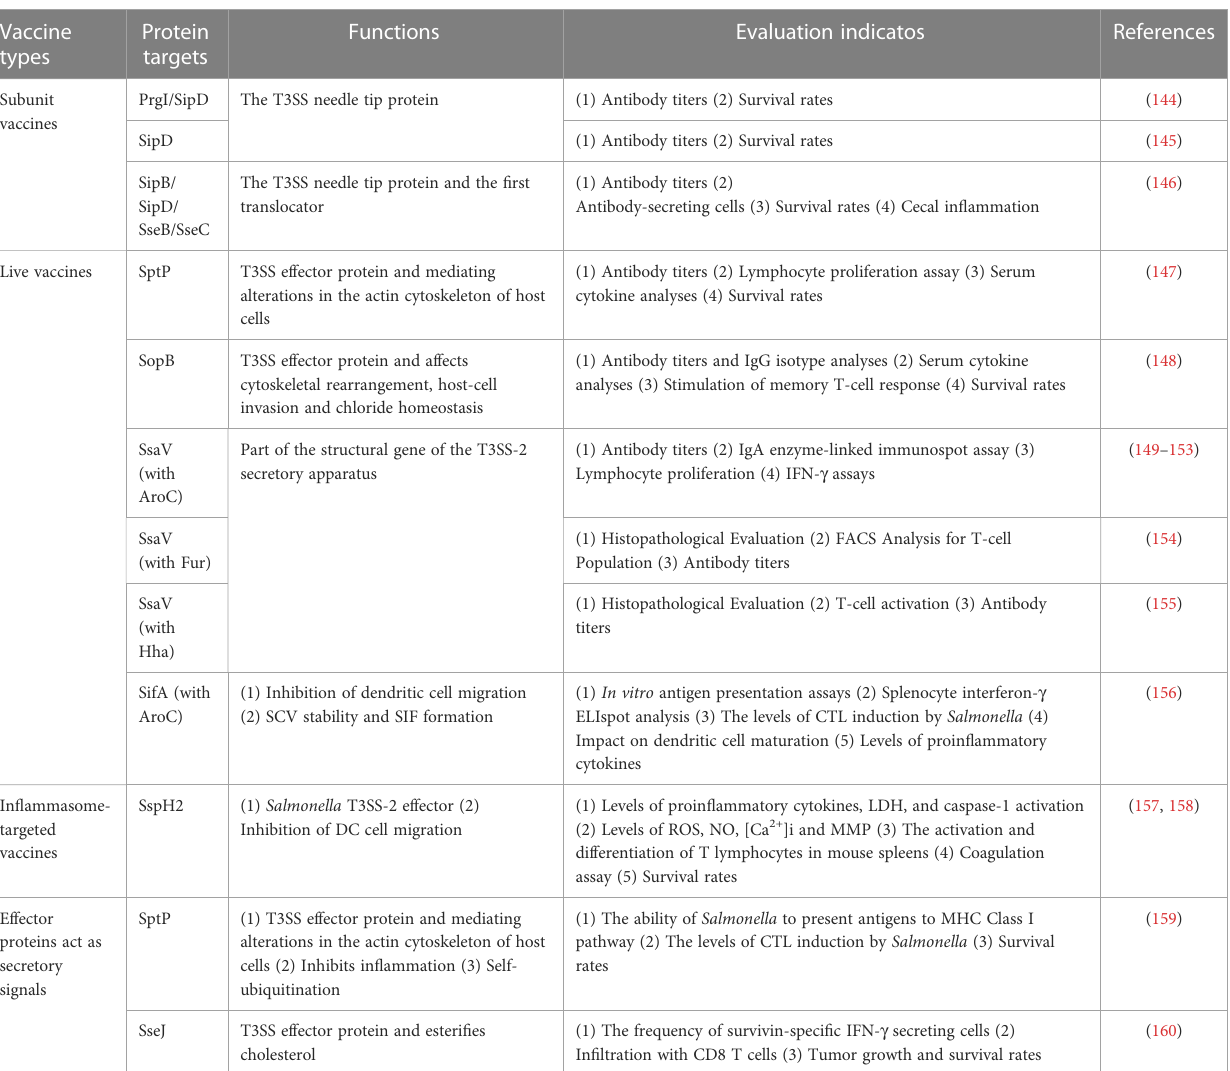
TABLE 2 Application of effector proteins in vaccine